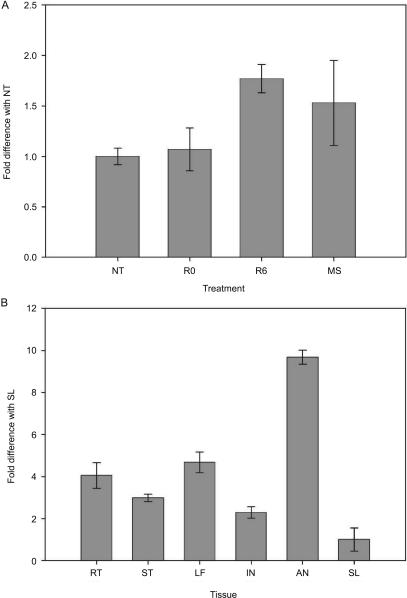
Real-Time qPCR Analysis of AtMUS81 Transcription(A) RNA from untreated (NT) plants, plants harvested immediately after gamma radiation treatment (R0), plants harvested 6 h after gamma radiation treatment (R6), and plants treated with 50 ppm MMS (MS) was used to measure the induction of the AtMUS81 transcript.(B) Real-time qPCR analysis of RNA from wild-type root (RT), stem (ST), leaf (LF), inflorescence (IN), anthers (AN), and silique (SL) tissue as a measure of tissue-specific AtMUS81 expression. The EF1 gene was used as a control. Error bars are +/− the standard error of the mean calculated from four replicates.